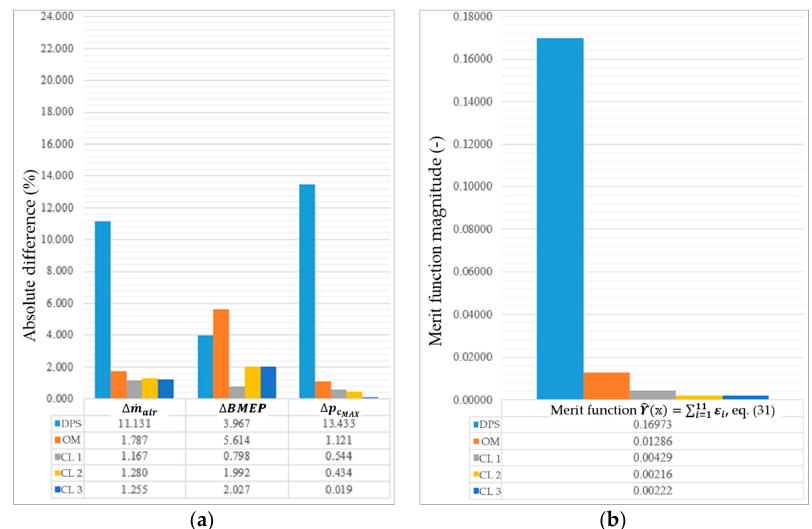
Figure 9. Comparison of absolute differences between the results of simulation and measurement for engine performance data (Table 2) and the merit function at 3800 rpm full-load steady-state operating point applying three different approaches for CBP determination in the applied ICESM. DPS represents simulation results achieved with the default CBPs available during the ICESM model set-up, OM results achieved by using one-step optimization method and CLs one to three simulation results obtained by the HCM employed in three CLs: ( a ) Absolute differences of the air mass-flow, BMEP and peak cylinder pressure p C , MAX ; ( b ) Magnitude of the merit function.